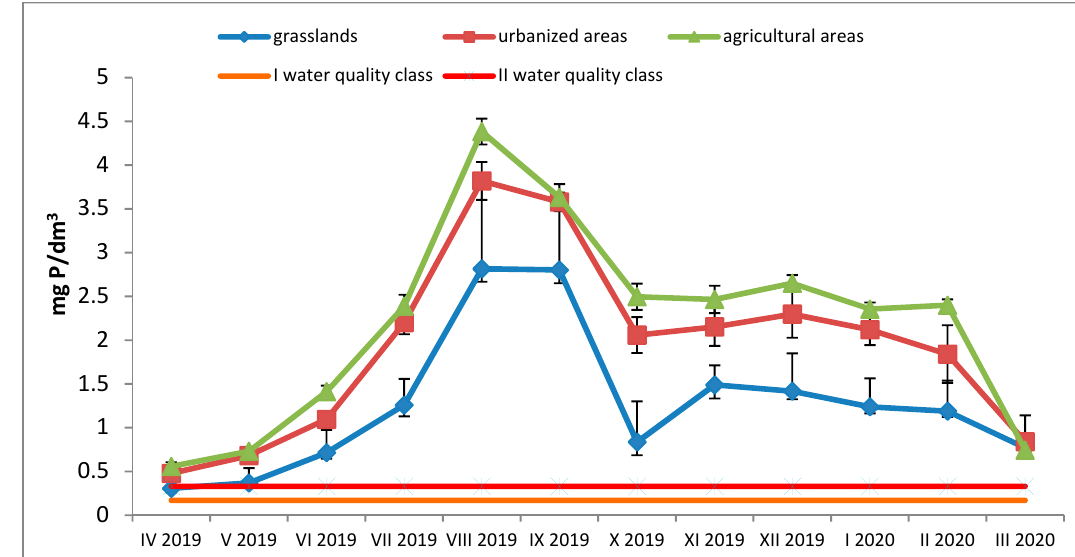
Figure 3. Mean and standard deviation for the total phosphorus concentration in the water as a function of sampling date and catchment area land use.